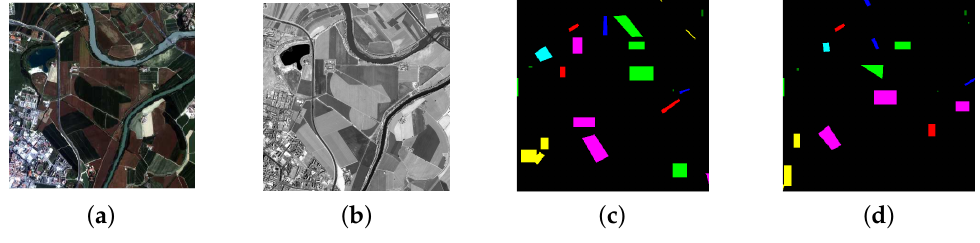
Figure 6. “Alessandria dataset”: ( a ) RGB true-color composition of the IKONOS multispectral channels, ( b ) panchromatic channel, ( c ) training map, and ( d ) test map. Color legend for the classes: urban , agricultural , rangeland , bare soil , forest , water , wet soil